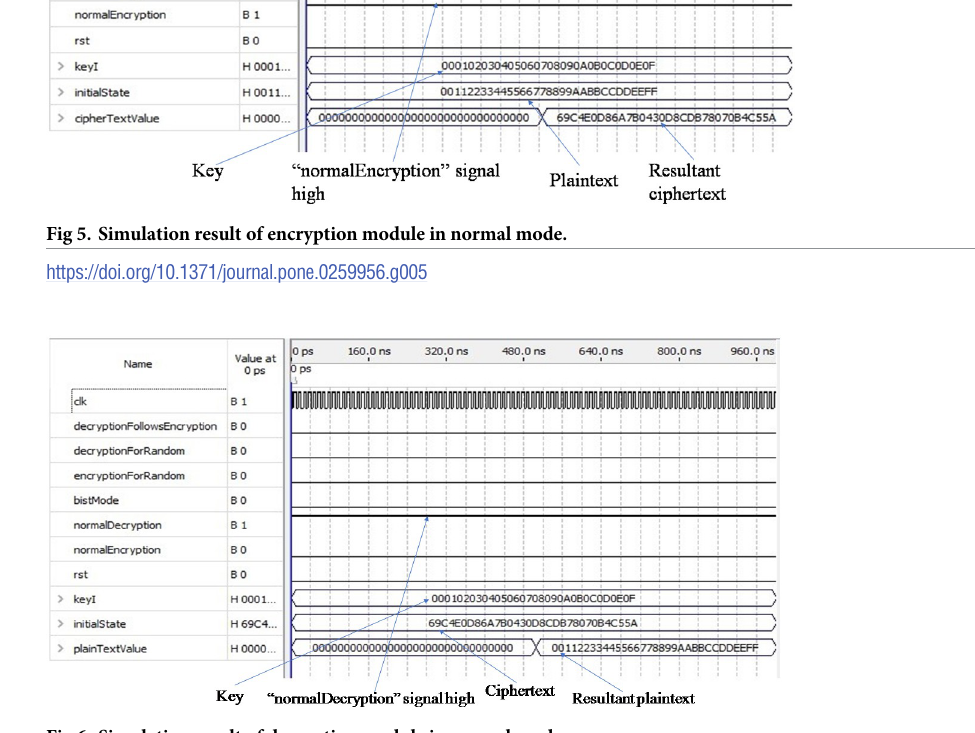
Fig 6. Simulation result of decryption module in normal